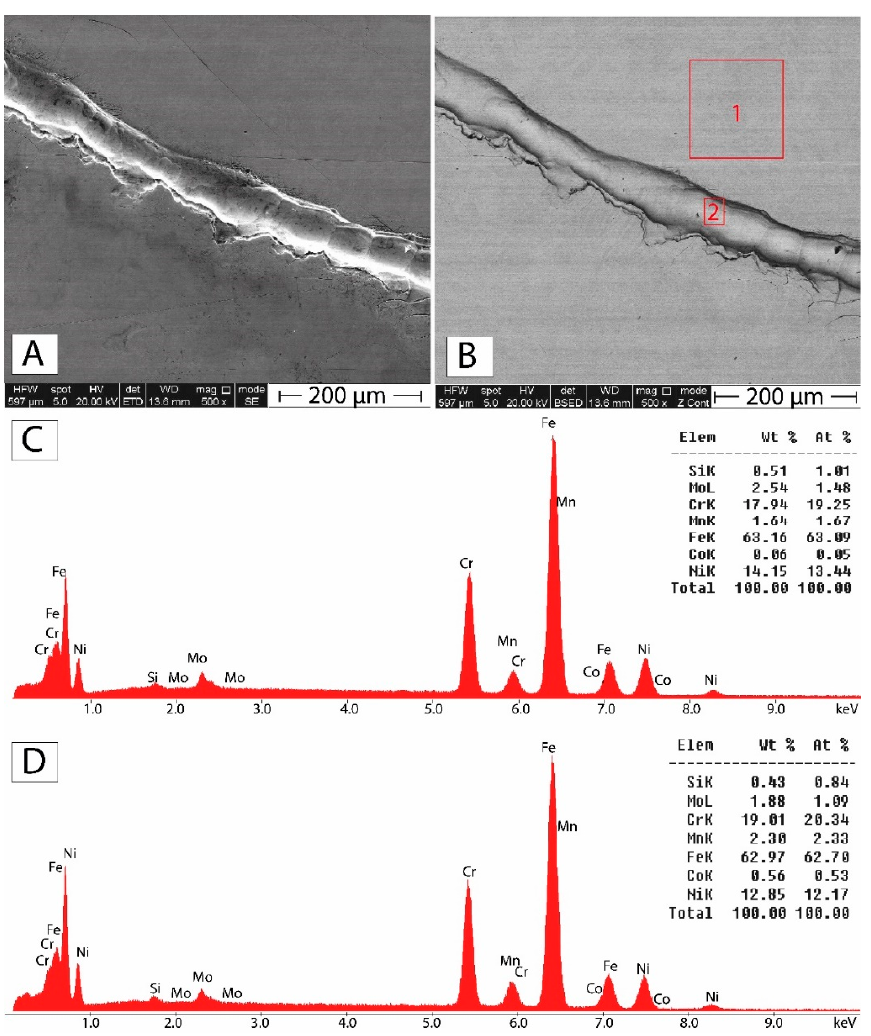
Figure 6. ( A ) Surface after corrosion test in SE, ( B ) surface after corrosion test in BSE with marked areas of EDX analysis, ( C ) EDX spectrum for area No.1, ( D ) EDX spectrum for area No.2 .